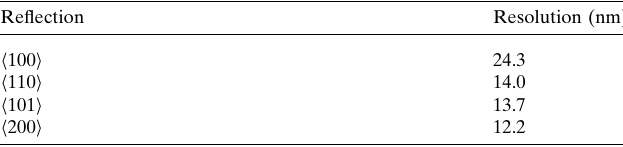
Table 1 Resolution for the peaks detected during this experiment.